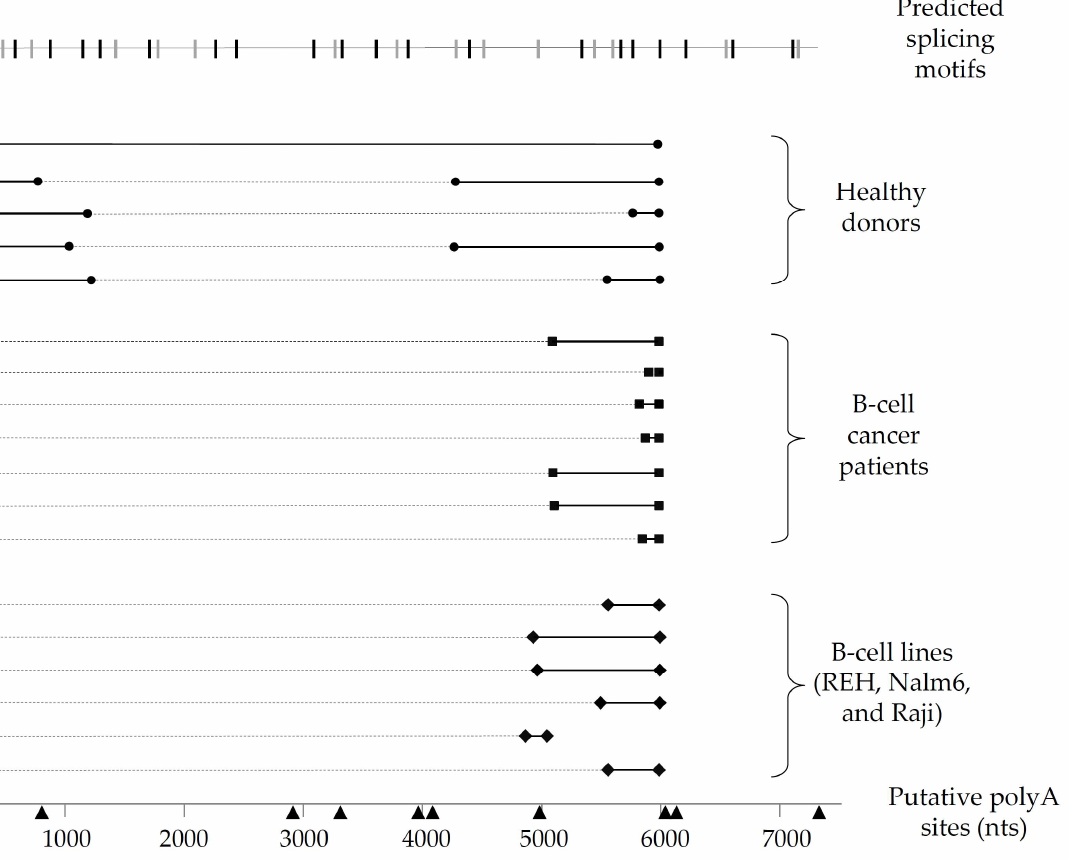
Figure 2. Schematic representation of Pax-5 3 (cid:48) UTR editing in B-lymphocytes. Pax-5 3 (cid:48) UTR pro- filing of splicing patterns was performed in B-lymphocytes from healthy donors (filled circles), B-cell cancer patients (filled squares), and B-cell cancer lines (filled diamonds). The bold black lines represent the complementary alignment with the referenced full-length Pax-5 3 (cid:48) UTR sequence (NCBI/NM_016734.3) [48], whereas the dotted gray lines represent the excised sequences from the spliced region. Putative polyA signals (black triangles) located at their respective nucleotide position (bottom line) were predicted for polyA canonical and non-canonical motifs using bioinformatics software tools (i.e., Softberry POLYAH, DNA polyA signal miner, and PolyA